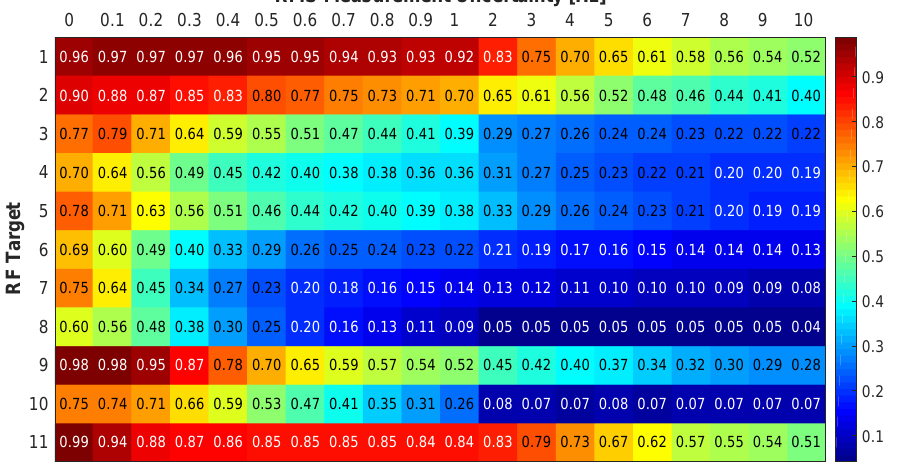
Figure 16. Correct association rate for matching specific cellular emanation measured by the constellation of RF receivers with the corresponding target from the multi-spectral video tracker using the absolute